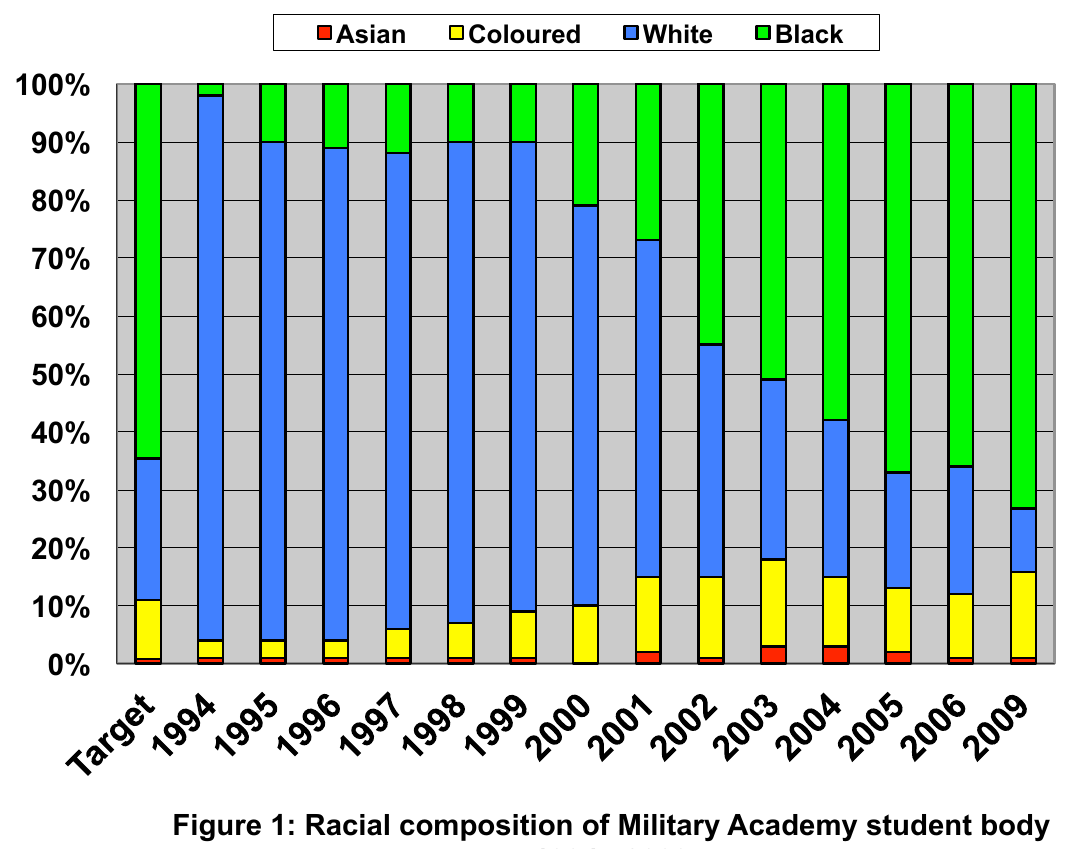
Figure 1: Racial composition of Military Academy student